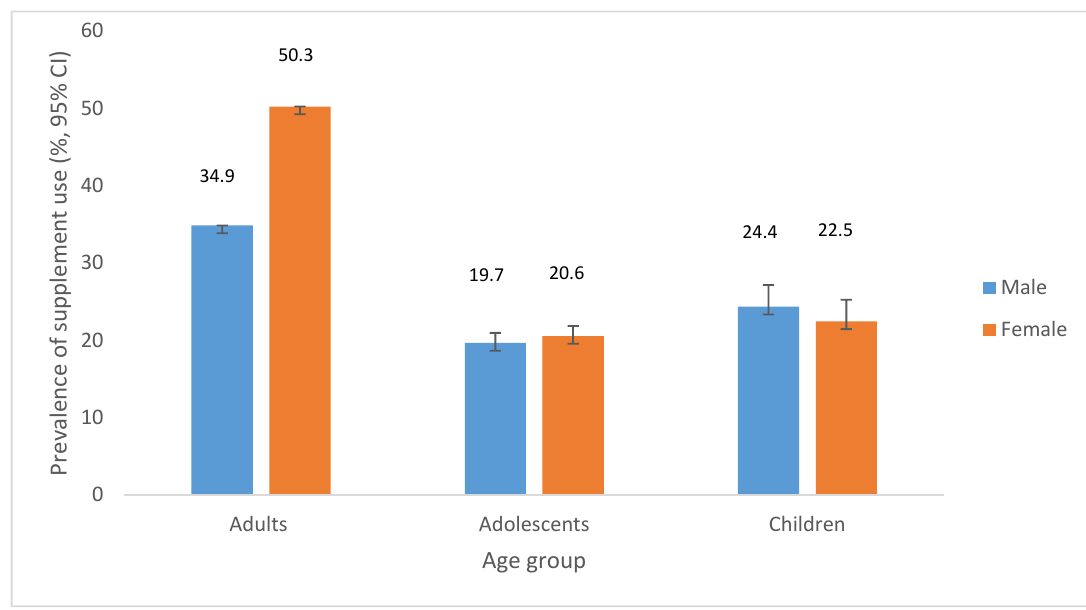
Figure 1. Prevalence (%, 95% CI) of supplement use in the previous two weeks for adults (aged ≥ 18